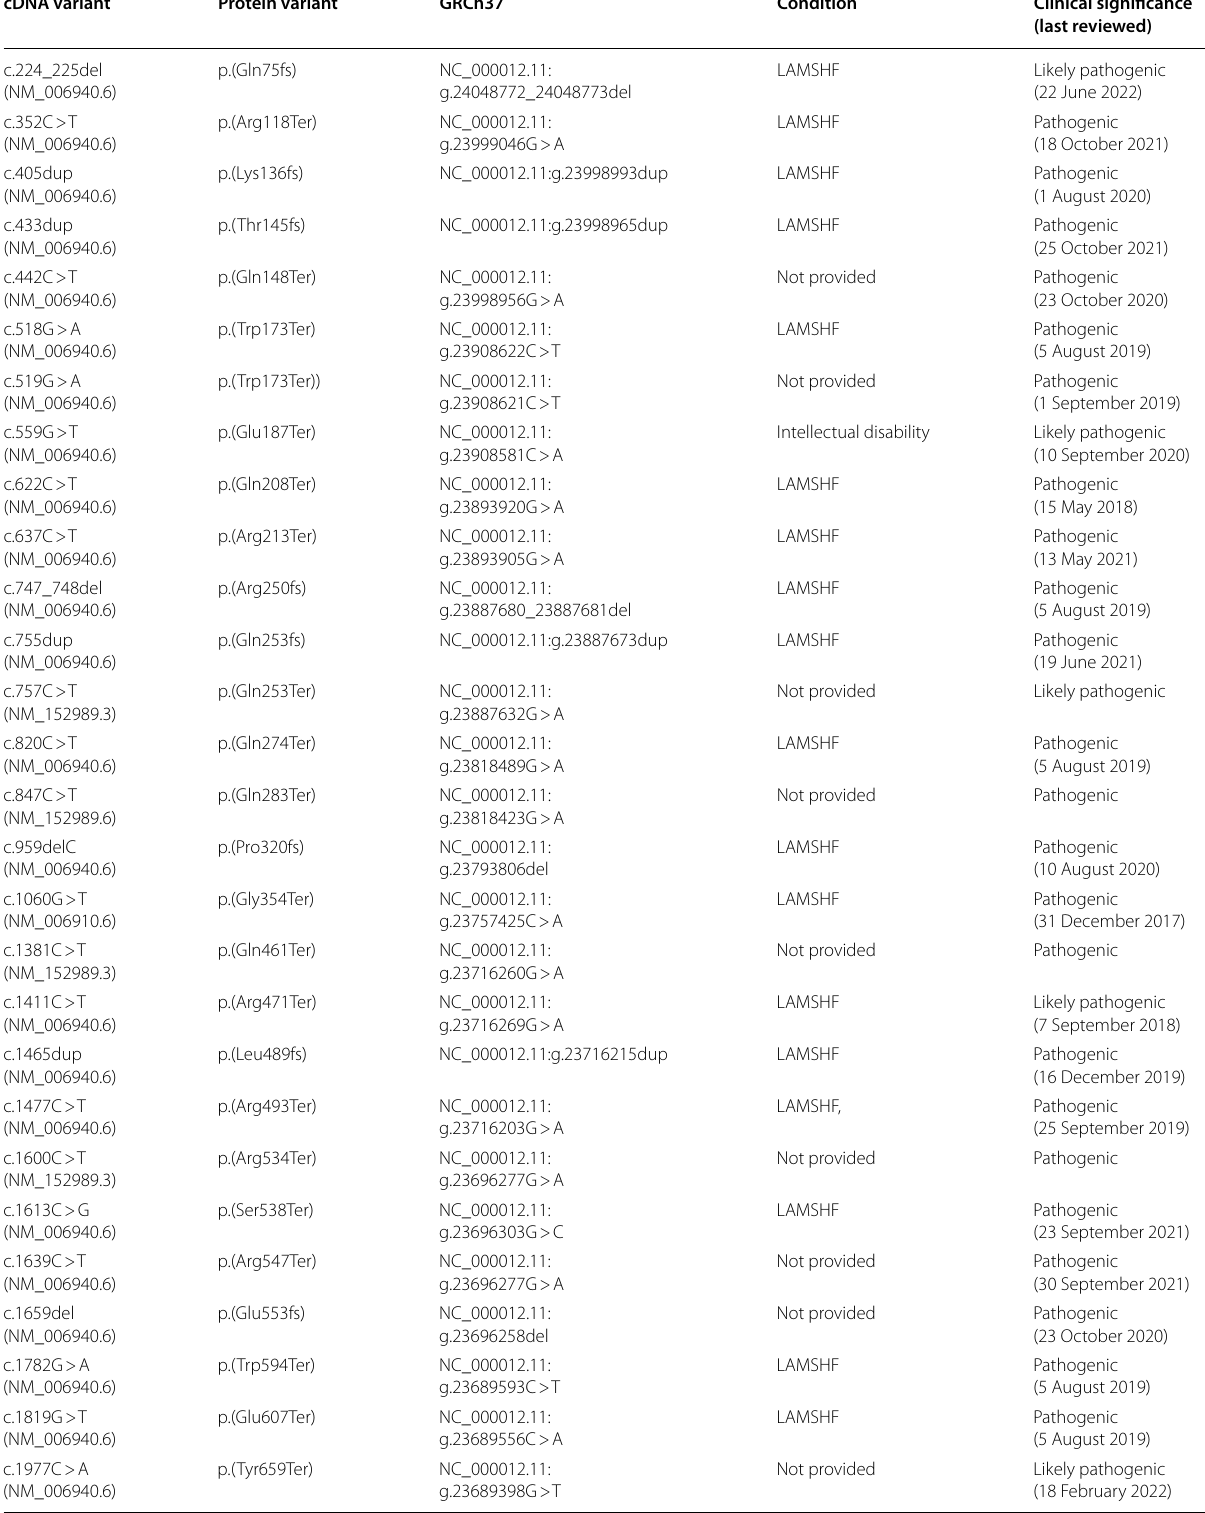
Table 2 Pathogenic variants of the SOX5 gene case described in the ClinVar [21] and LOVD [22]